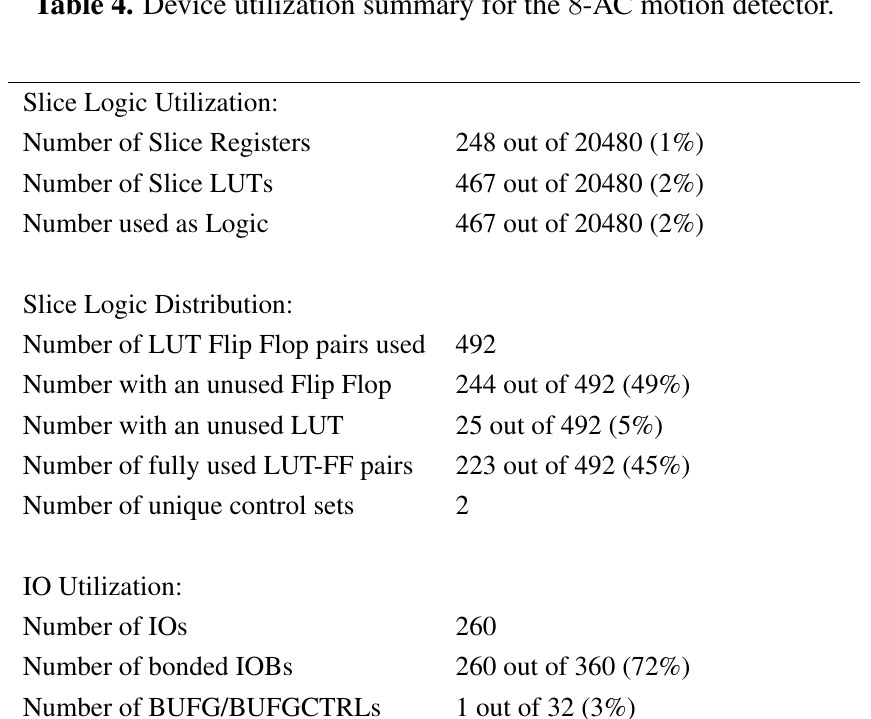
Table 4. Device utilization summary for the 8 -AC motion